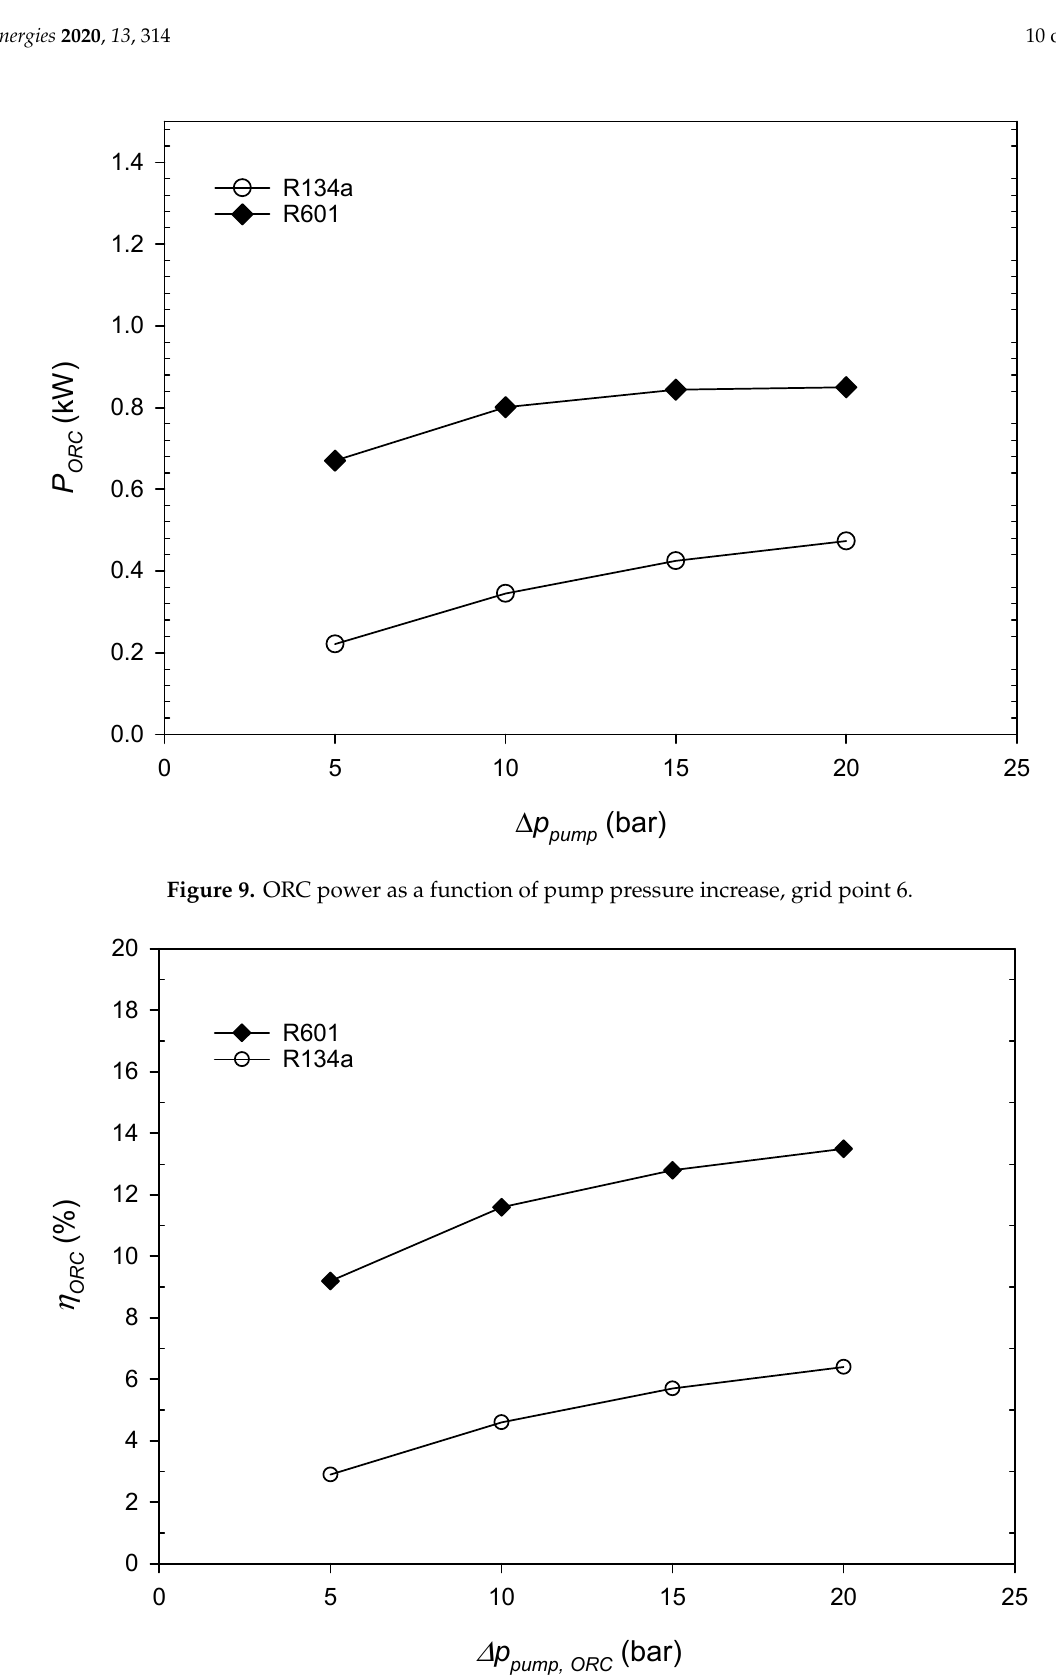
Figure 10. ORC efficiency as a function of pump pressure increase, grid point 6.